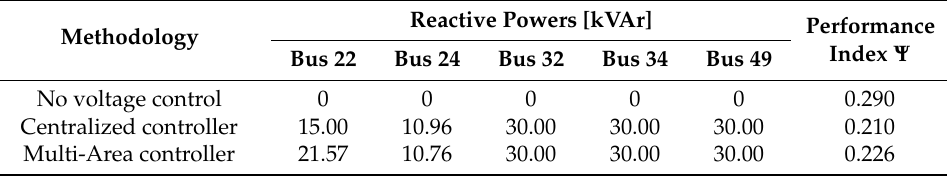
Table 2. Comparison of the proposed method’s results with a centralized methodology.